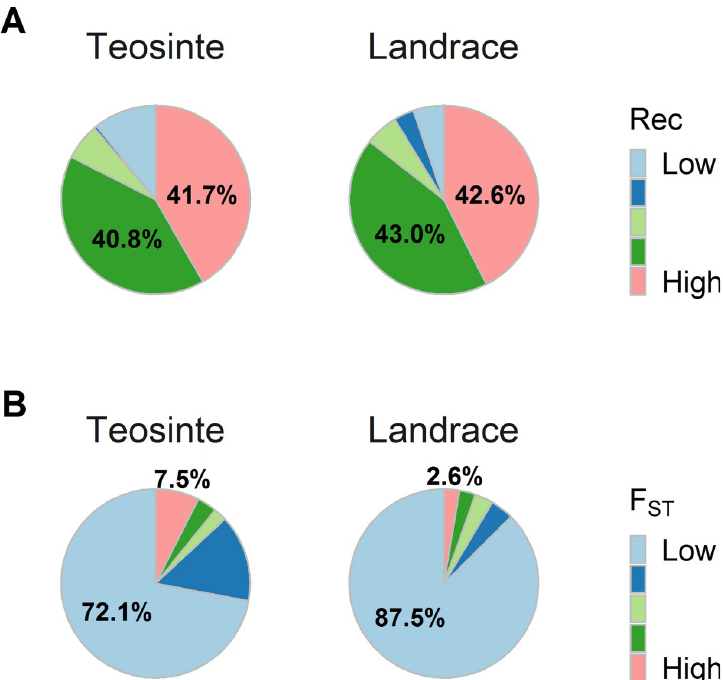
Fig 7. VCAP by different genomic features. (A) Five kinship matrices were calculated by SNPs in quintiles of the 10 kb recombination rates after accounting for gene density and then variances were estimated for each kinship. Rec stands for the residual of recombination rate after regression for gene density. (B) Five kinship matrices were calculated by SNPs in quintiles of the F ST value and then variances were estimated for each